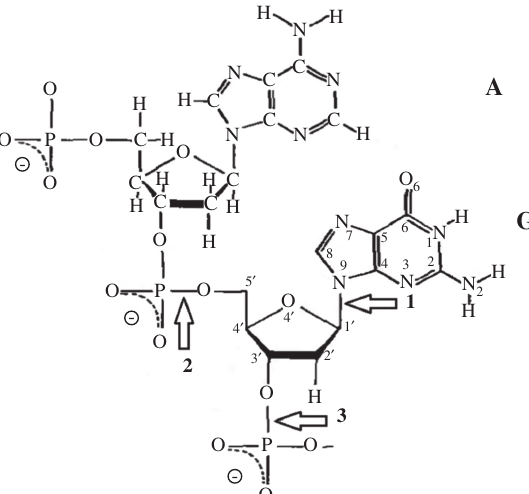
Figure 26 Segment of polynucleotide DNA change 1- glycoside link, 2- and 3- phosphordiester